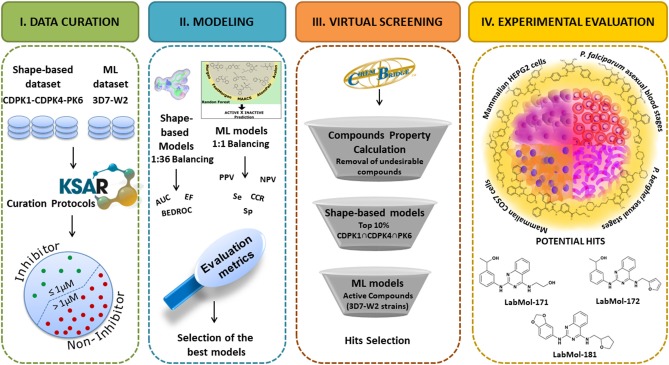
Overall pipeline designed for the identification of new antiplasmodial compounds.